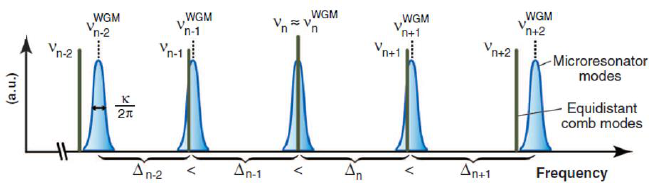
Figure 3 Whispering-gallery-mode Laser